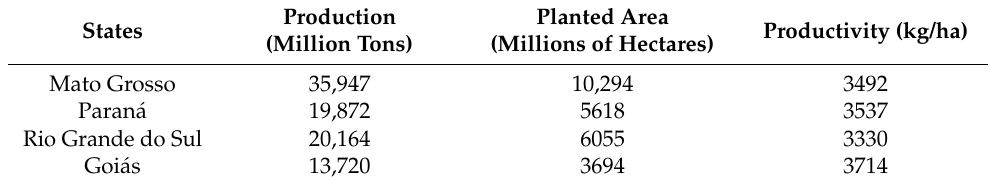
Table 6. The Brazilian states that most produced soybean 2020–2021 (million t). Source: [22].